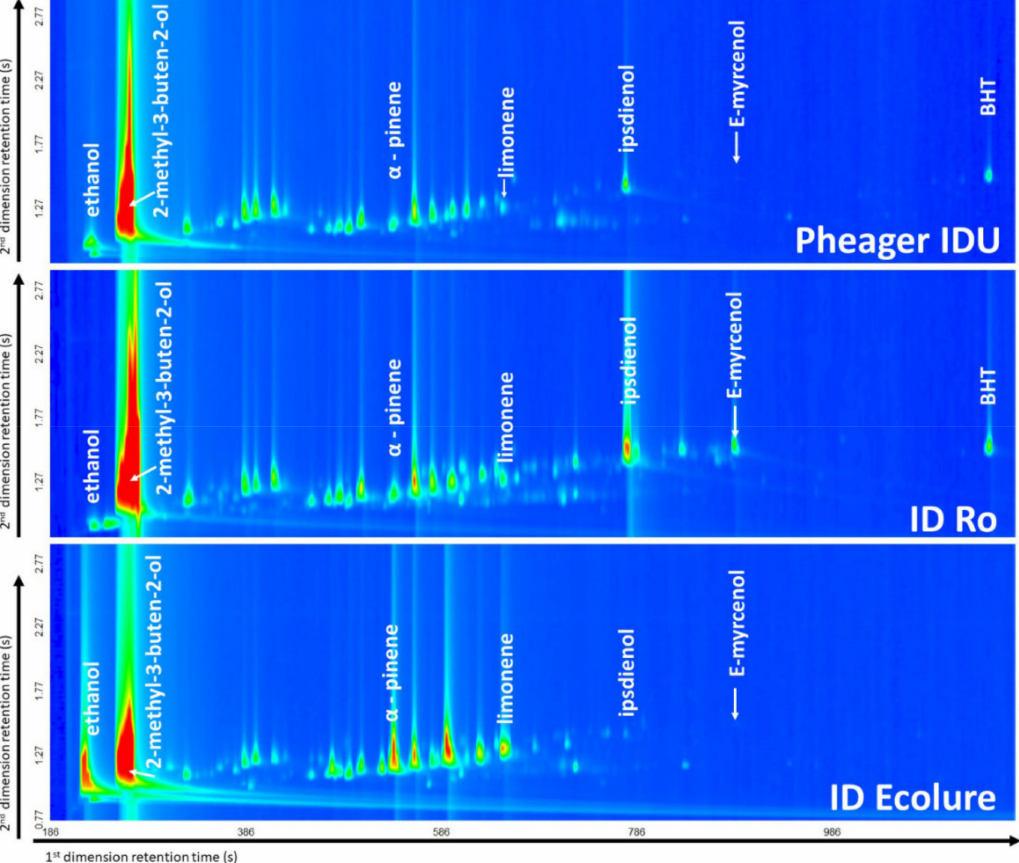
Figure 2. Headspace analysis of active compounds in dispensers tested in 2017. GC × GC chro- matograms of volatiles collected to SPME fibres. Volatiles were collected on the second day after dis- penser opening. Dispensers were heated to 50 ◦ C. The x -axis is retention time on the first-dimensional column, y -axis is retention time on the second-dimensional column. Only chromatographic peaks of the active compounds, solvent, and antioxidant are